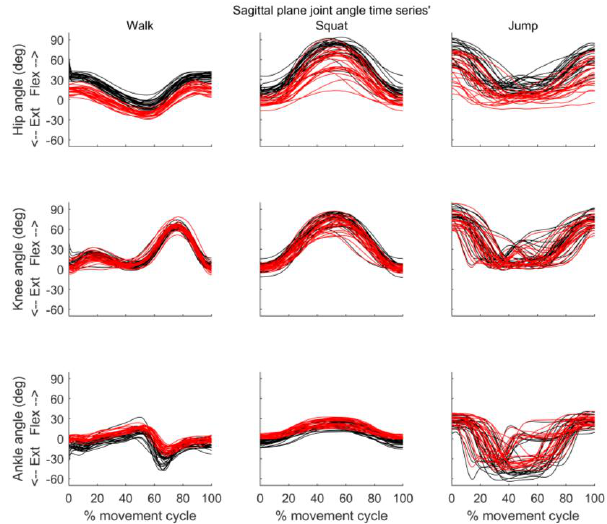
Figure 5. Sagittal plane joint angles throughout the movement cycle for each participant. Time series of hip ( top row ), knee ( middle row ) and ankle ( bottom row ) joint angles obtained from VICON (black) and MVN BIOMECH (red) systems for each participant during walk ( left ), squat ( centre ), and jump ( right ). Y-axis represents joint angles in degrees and X-axis represent the movement cycle in percentage.